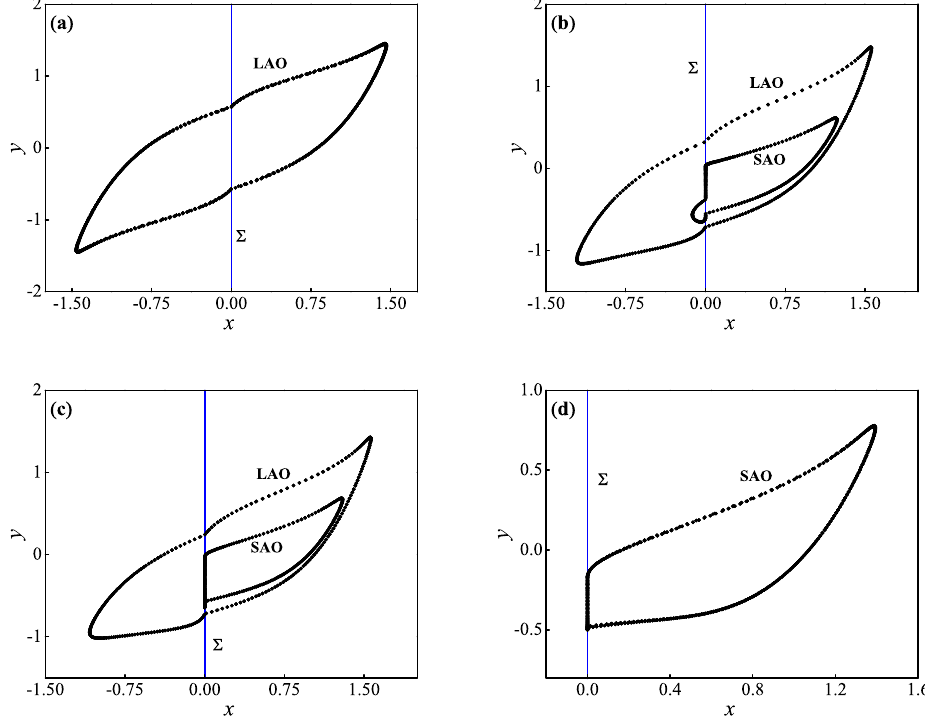
Figure 4. Poincaré maps of the MTSOs with Ω = 0.01. ( a ) Π 1 : = w = 0; ( b ) Π 2 : = w = 0.46; ( c ) Π 2 : = w = 0.55; ( d ) Π 2 : = w =